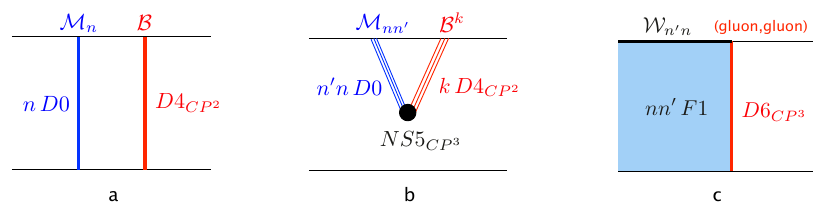
Figure 7 . AdS 4 dual of (SU( N ) k (cid:2) SU( N ) k ) = Z n 0 : (a) n -dressed-monopole and di-baryon opera- (cid:0) tors. (b) Chiral ring relation. (c) N = nn 0 fundamental Wilson lines screened by gluons. Z n (cid:12)xed boundary condition for B allows string worldsheets to end on the boundary